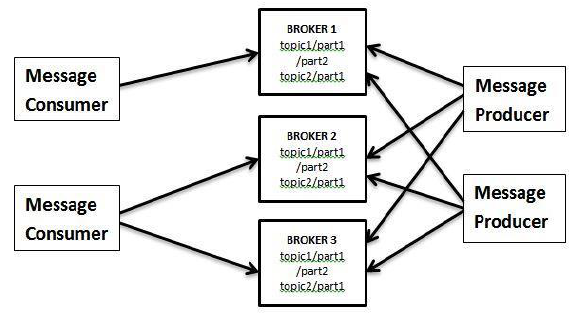
Figure 2. Kafka Architecture [2]